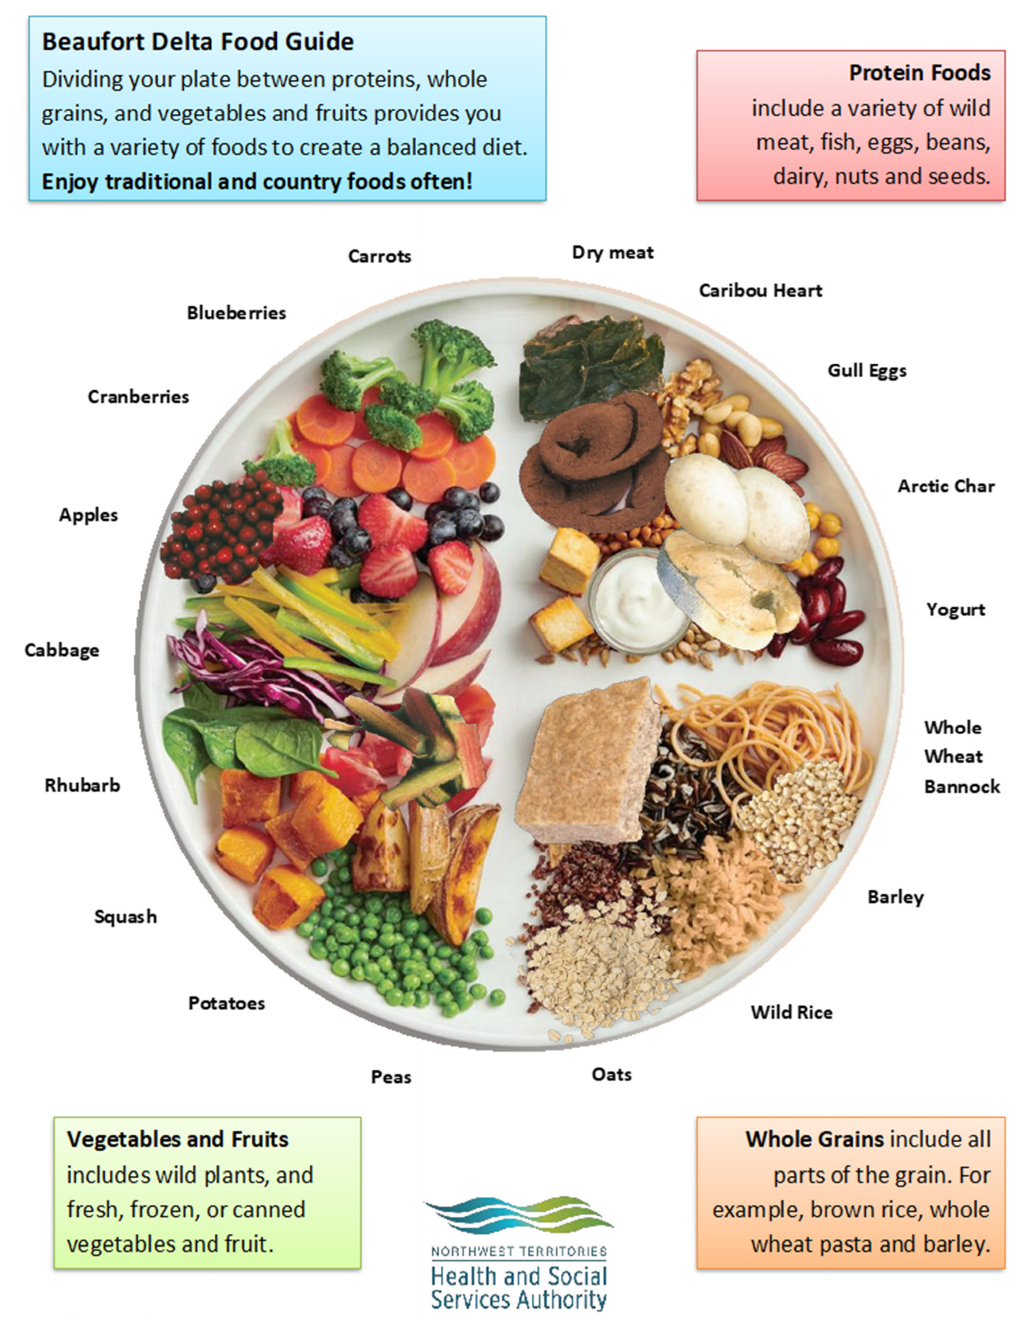
Figure 1. Beaufort Delta Food Guide [43].